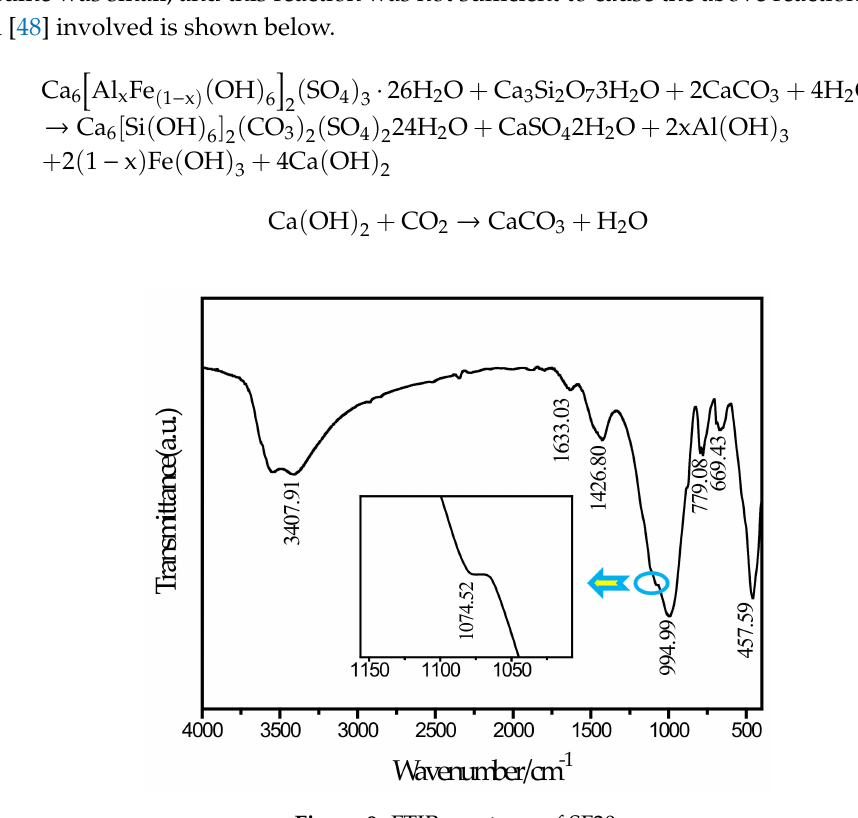
Figure 9. FTIR spectrum of